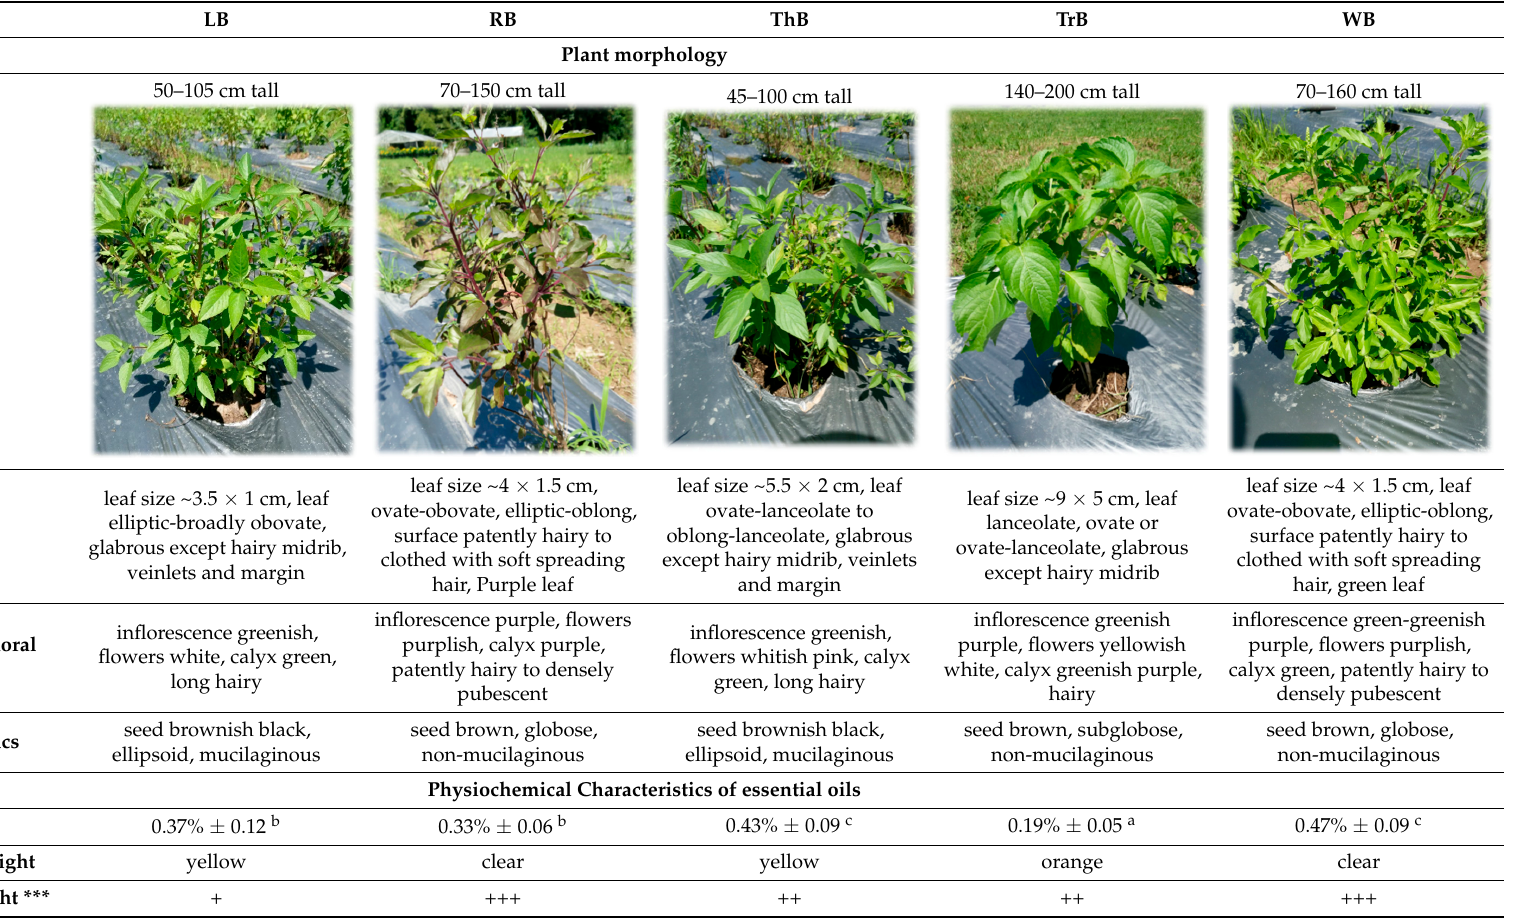
Table 2. Morphology of five Ocimum spp. and physiochemical characteristics of their essential oils.